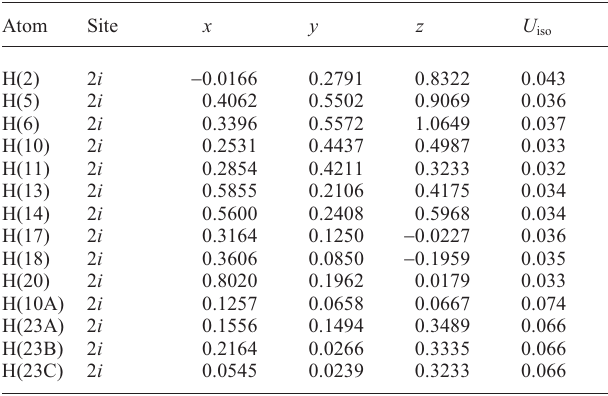
Table 2. Atomic coordinates and displacement parameters (in Å 2 )